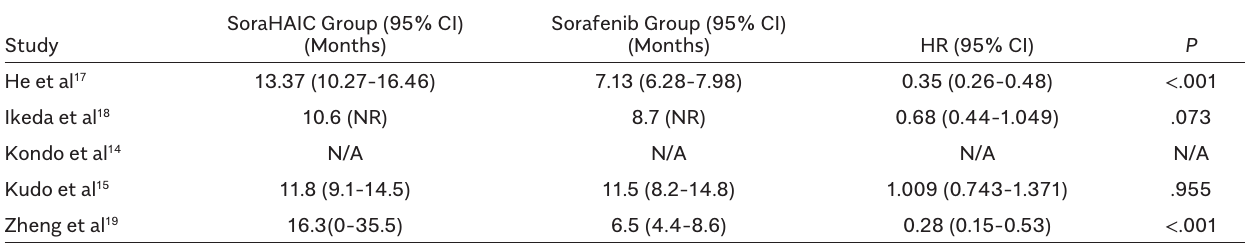
Table 2. The Median OS and HR in 2